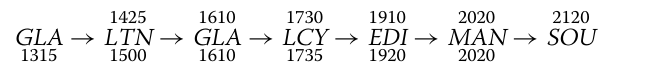
at1300andtakingtheshortestpossible(eveninstantaneous)layovers,wehavethe sequenceofnominallyconnectingflights